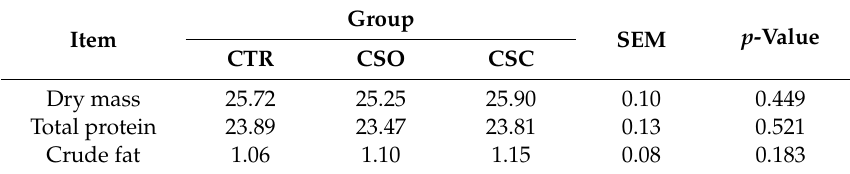
Table 6. Results of the chemical analysis (%) of the breast muscles ( Pectoralis major